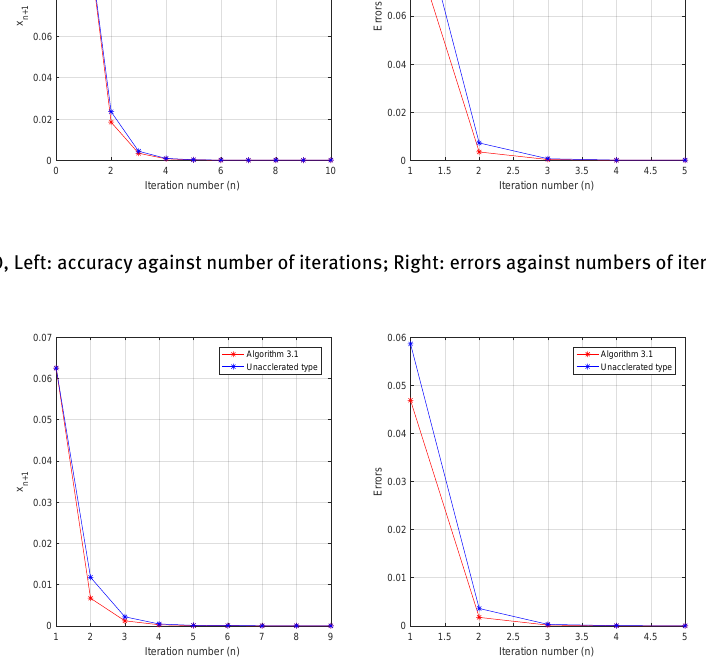
Figure 3: x 1 = 0.0625 , Left: accuracy against number of iterations; Right: errors against numbers of iterations.